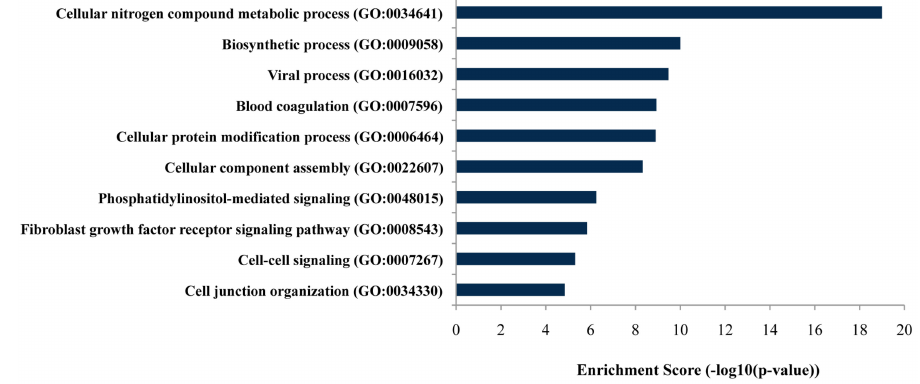
Figure 2. Bar plot ranking of the top ten biological processes based on enrichment score by gene ontology (GO) analysis.